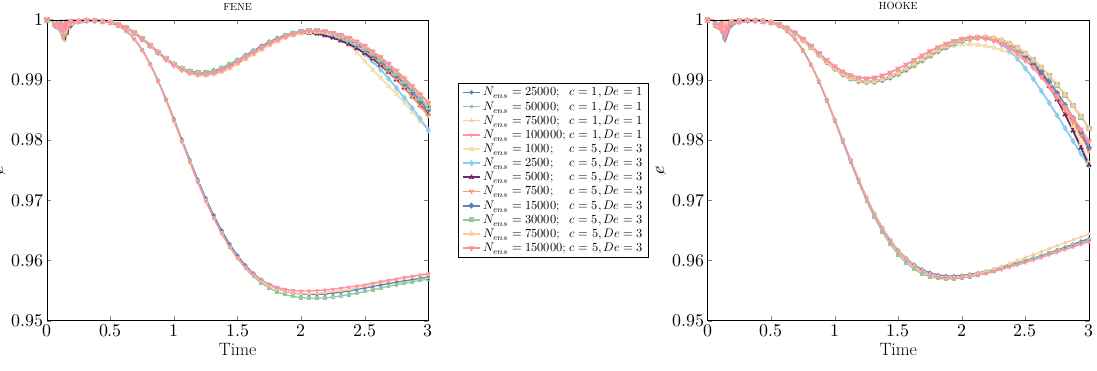
Figure 8. Evolution of the circularity of a drop rising due to buoyancy effects in a polymer solution, using the FENE and Hookean kinetic models, variable number of ensembles ( N ens × N d = 750 × 10 6 ), and different degrees of viscoelasticity: c = 1, De = 1; and c = 5, De =